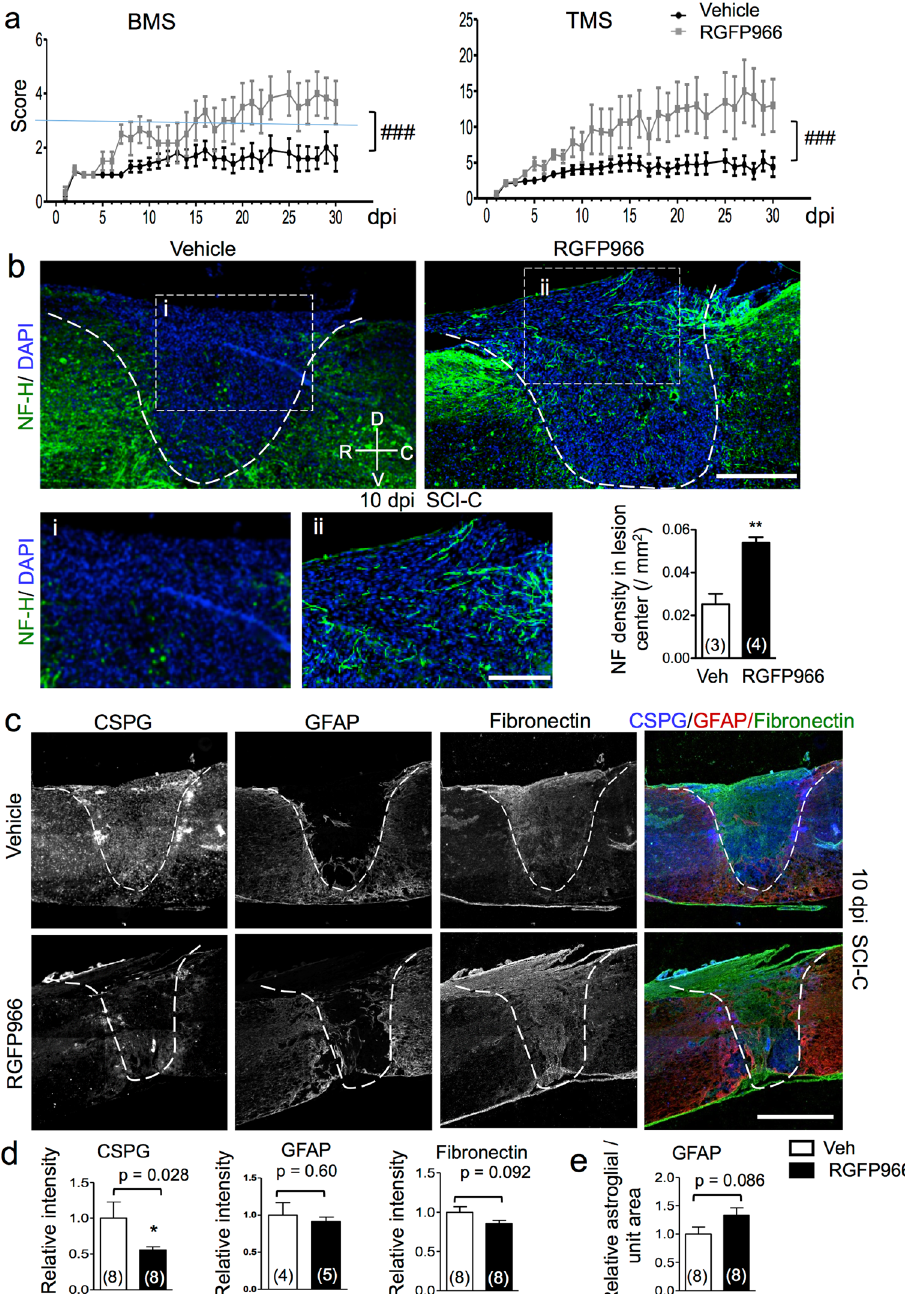
Figure 4. HDAC3 inhibition improves functional recovery and enhances neuroprotective phenotypes after SCI. ( a ) Behavioral assays demonstrate improved and sustained functional recovery by both BMS and TMS scores up to 30 dpi after contusion injury. Blue line in the BMS score denotes weight-bearing threshold. Repeated measures, two-way ANOVA with Bonferroni post hoc correction. ### p < 0.001. n = 10 for vehicle and n = 6 for RGFP966 cohort. ( b ) Representative images and quantification show increased density of axon fibers, identified by NF-H immunolabeling (green), in lesion center at 10 dpi after contusion injury (SCI-C). Lesion border is indicated by dashed lines. DAPI was used for nuclear counterstaining. Enlarged images of boxed areas are shown below. n = 3 mice for vehicle and 4 mice for RGFP966 cohort, with 1–4 representative images averaged for each animal. ** p < 0.01, unpaired Student’s t-test. ( c – e ) Representative images and quantification of SCI scar constituents at 10 dpi after contusion: CSPG (blue), GFAP (red), and Fibronectin (green). Lesion border is indicated by dashed lines. The number of animals quantified is shown inside the bar graph, with 2–5 representative image averaged for each animal. Quantification showed a decrease in CSPG with RGFP966 treatment, p = 0.028, Mann Whitney test, but no significant change in GFAP and a trend of decrease in Fibronectin (unpaired Student’s t test). The astroglial scar size was also not significantly changed (unpaired Student’s t test). Scale bars: 100 µ m ( b ), 50 µ m (i and ii in b ), and 500 µ m ( c